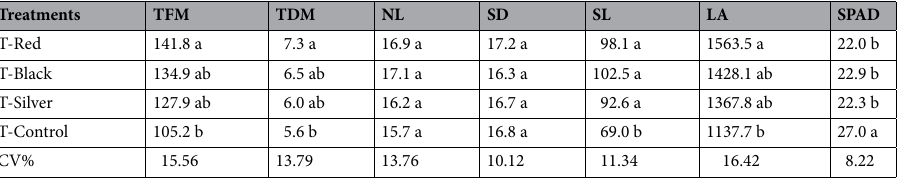
Table 4. Average values of total fresh and dry matter (GFR and TDM in g), number of leaves (NL), stem diameter (SD in mm), stem length (SL in mm), leaf area (LA in cm 2 ) and chlorophyll index (SPAD) of purple lettuce cultivated in different photo-selective screens and in full sun. Means followed by the same letter do not differ from each other at the 5% probability level (p < 0.05) by the Tukey test.